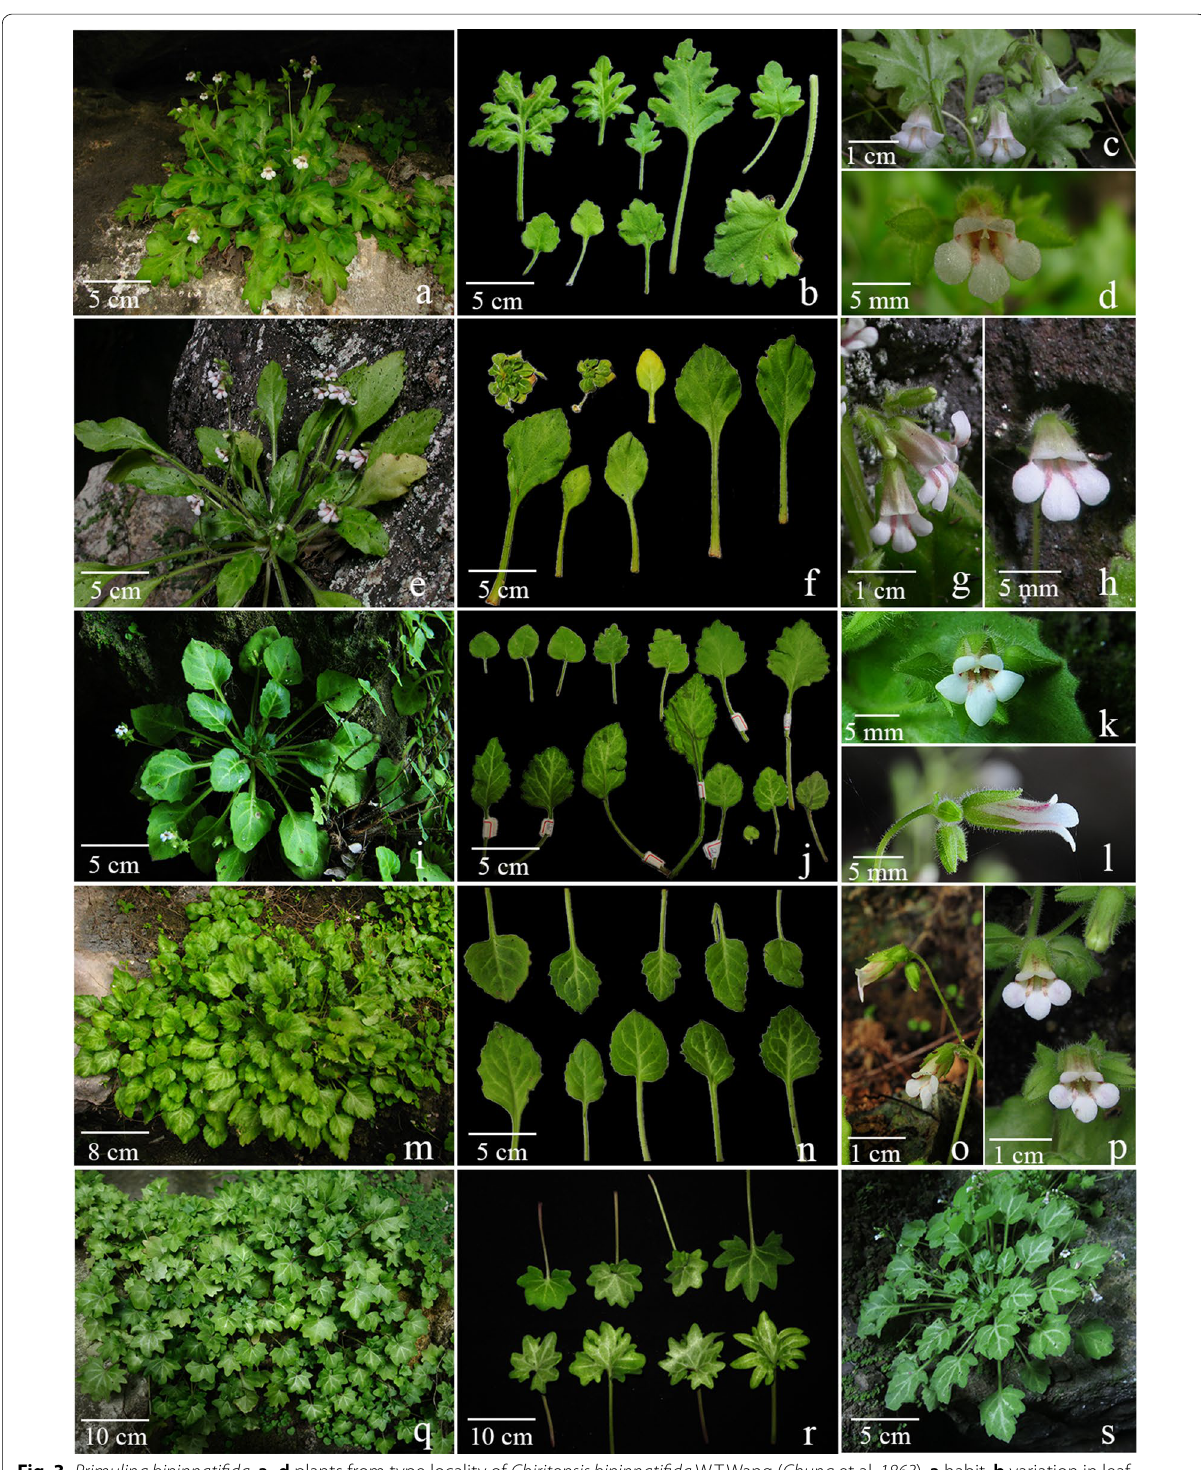
Fig. 3 Primulina bipinnatifida . a – d plants from type locality of Chiritopsis bipinnatifida W.T.Wang ( Chung et al . 1863 ), a habit, b variation in leaf shapes, c flowers (side view), d flower (face view); e – h plants from type locality of C. lingchuanensis Yan Liu & Y.G.Wei ( Chung 1802 ), e habit, f variation in leaf shapes, g flowers (side view), h flowers (face view); i – l plants from type locality of P. jianghuaensis K.M.Liu & X.Z.Cai ( Chung 2932 ), i habit, j variation in leaf shapes, k flower (face view), l flower (side view); m – p plants from type locality of P. cangwuensis X.Hong & F.Wen ( Chung 1842 ), m habit, n variation in leaf shapes, o flowers (side view), p flowers (face view); q , r plants from type locality of P. zhoui F.Wen & Z.B.Xin ( F. Wen WF150718 ‑ 01 ), q habit, r variation in leaf shapes; s a plant from Lipu ( Chung 1852